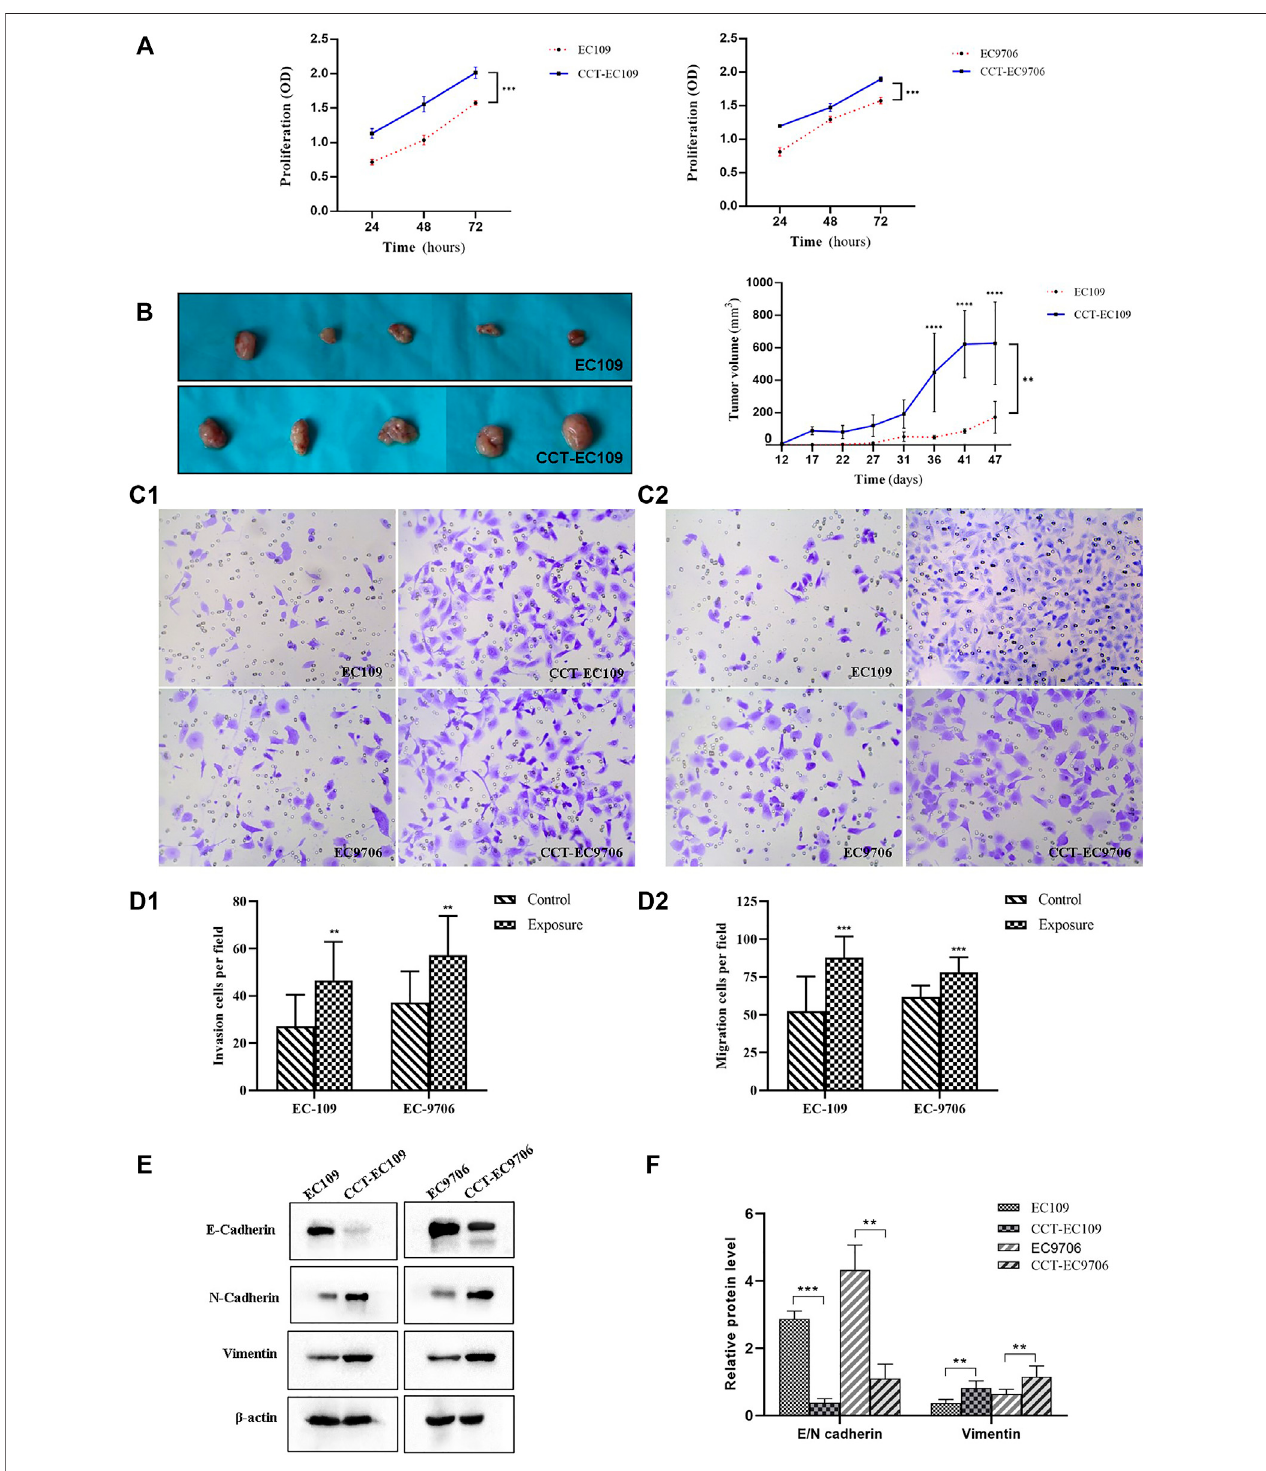
FIGURE 3 | Cell proliferation was determined by MTT assay in EC109 (left panel) and EC9706 (right panel) cells following 5 μ M Cd treatment for 10 weeks (A) . Comparison xenograft tumor growth between EC109 and CCT-EC109 xenograft mice (n = 5) (B) . Invasion was determined by transwell assays with Matrigel (magni fi cation ×100) (C1,D1) and migration was assessed by transwell assay without Matrigel (C2,D2) . Representative Western blot image and the corresponding quantitative analyses for the expression of EMT biomarkers (E-cadherin, N-cadherin and vimentin in ESCC cells with the presence and absence of Cd (E,F) . The values are mean ± SD from three independent experiments. Results are presented as mean ± SD from three independent experiments. * p < 0.05; ** p < 0.01; *** p < 0.001, compared with the controls.